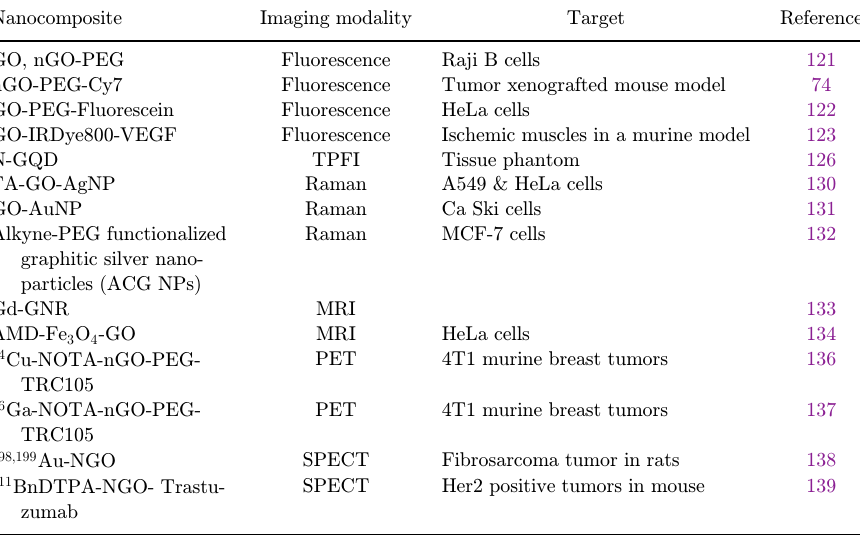
Table 5. Summary of graphene-based nanomaterials for